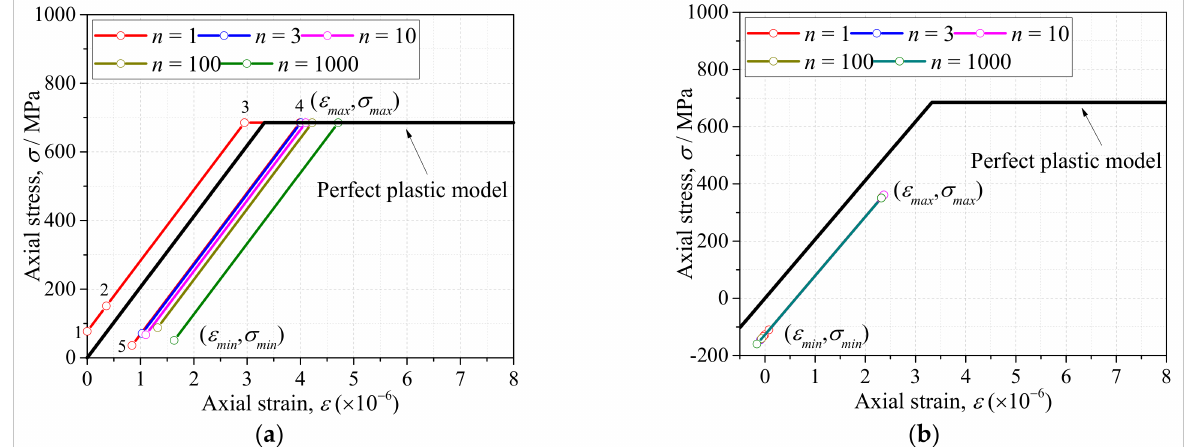
Figure 7. The stress-strain relationship of weld toe by perfect plastic model: ( a ) Specimen AW; ( b ) Specimen